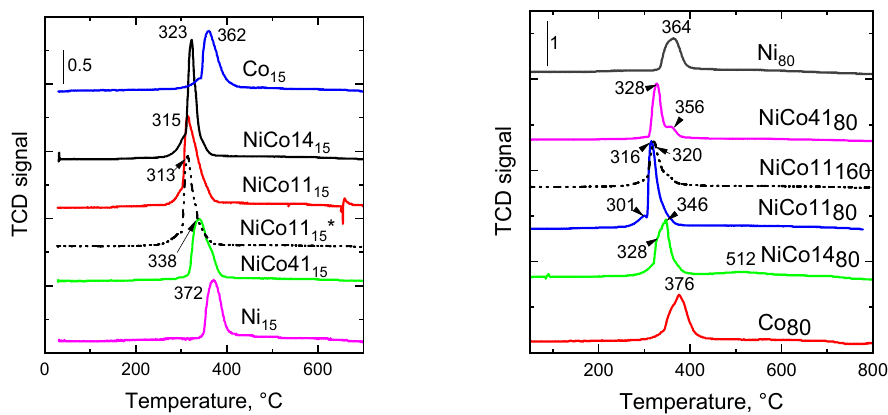
Figure 4. Temperature-programmed reduction of the catalysts prepared at deposition pressures of 15 and 80 15 and 80 Pa.